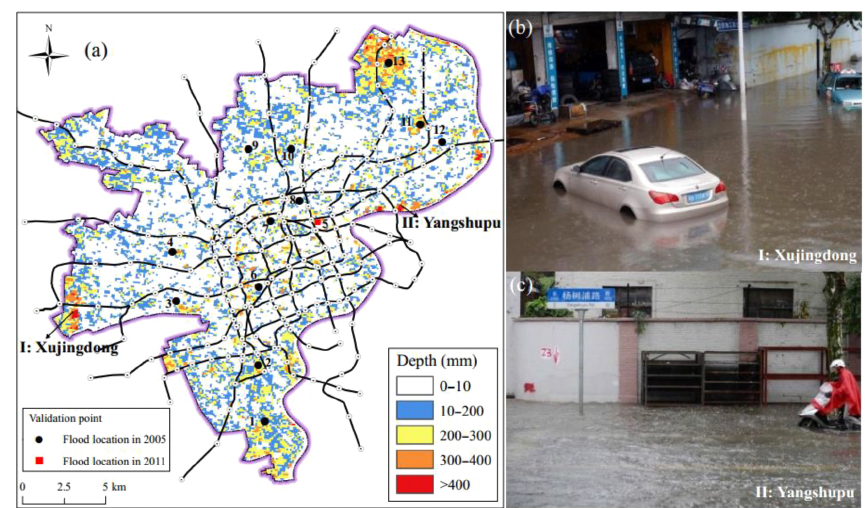
Figure 8. Distribution of the recorded flood locations: (a) recorded flood locations, (b) inundation of Xujingdong Road, and (c) inundation of Yangshupu Road.